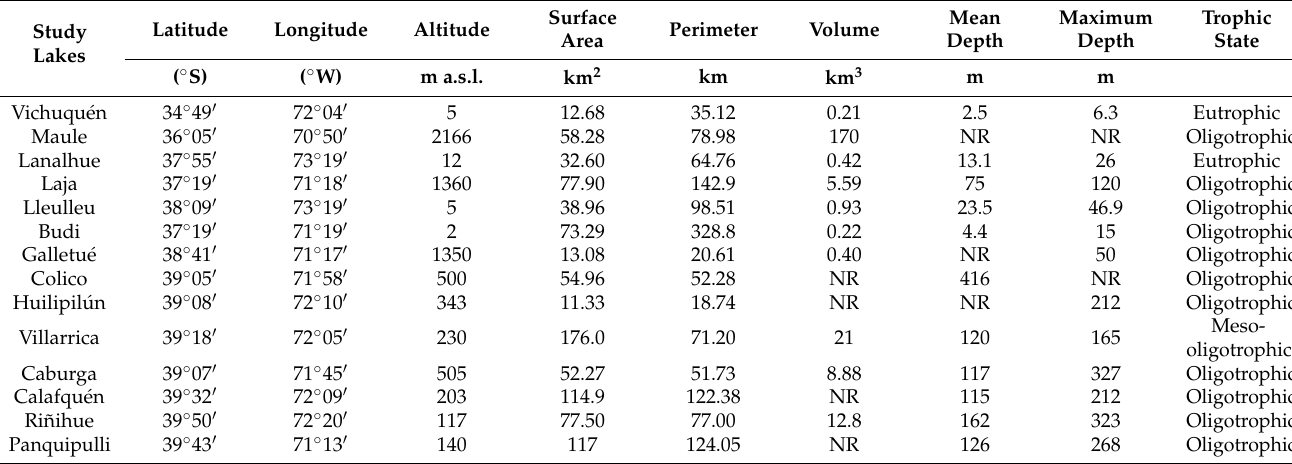
Table 1. Morphometric parameters that influence LSWT: location, elevation, surface area, perimeter, volume, mean depth and maximum depth for the 14 inland lakes selected in this